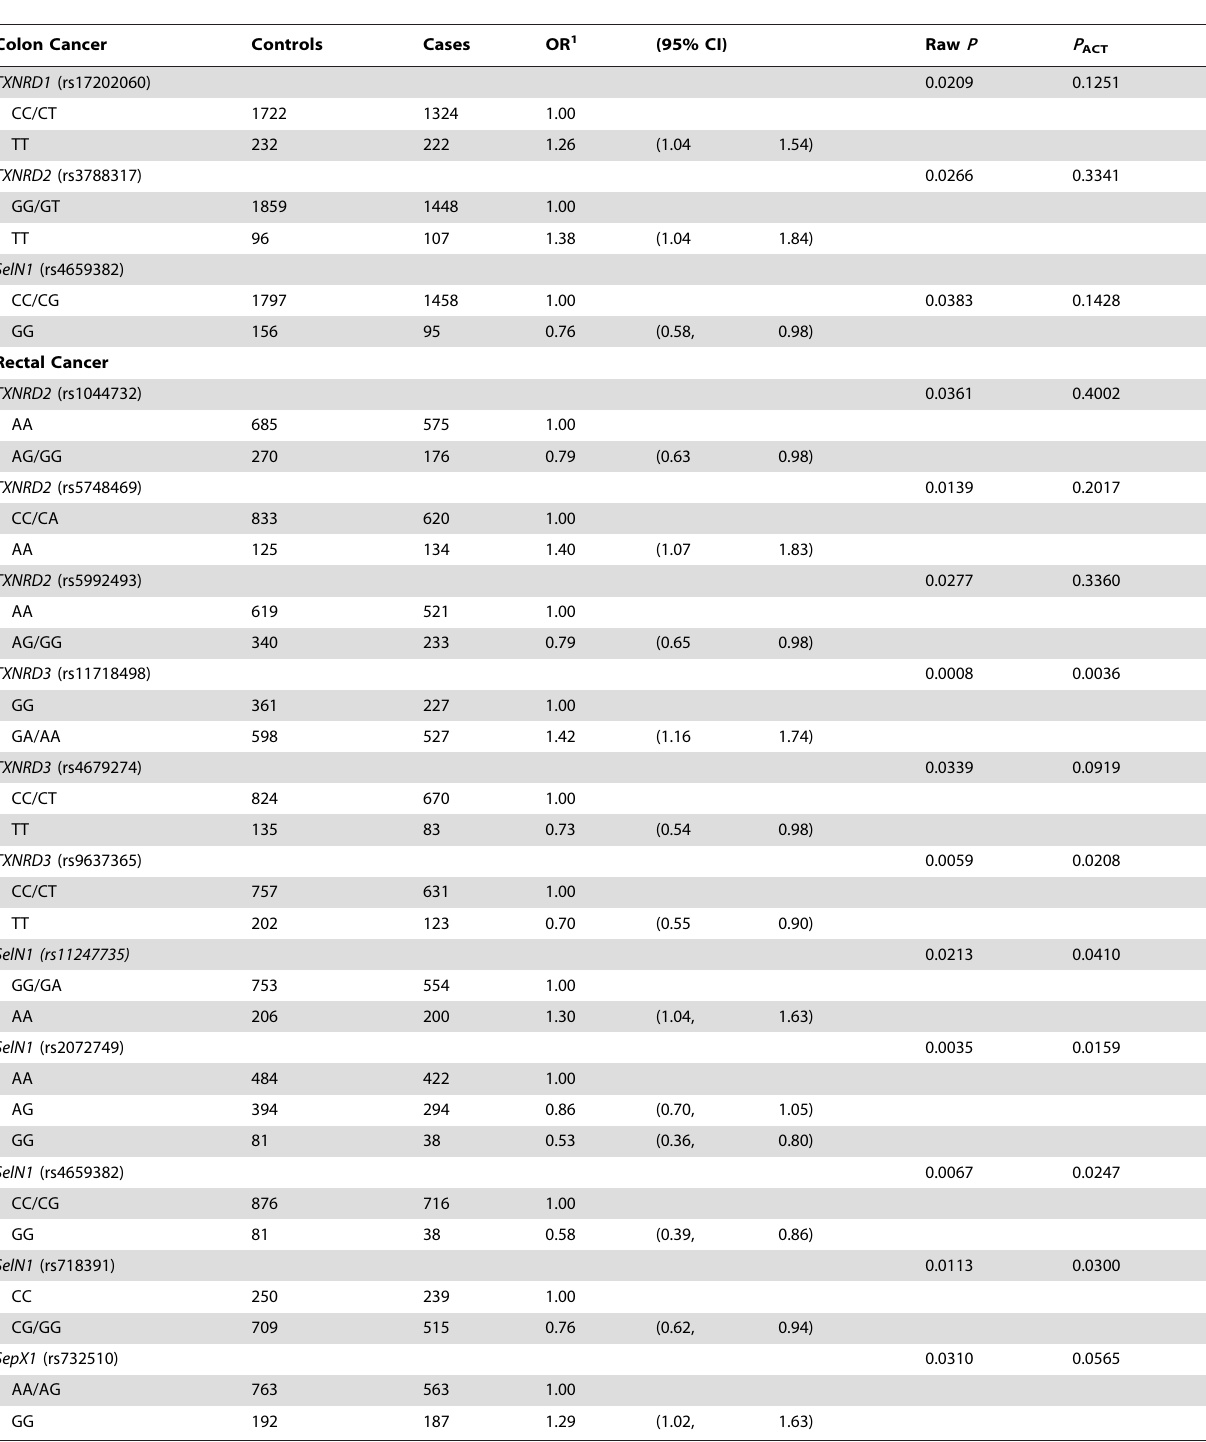
Table 2. Associations between TXNRD1 , TXDRD2 , TXNRD3 , SelN1 , and SepX1 and colon and rectal cancer.